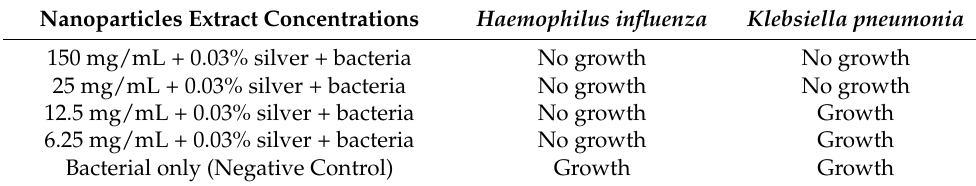
Table 1. The H. influenza and K. pneumonia growth were tested for 24 h.